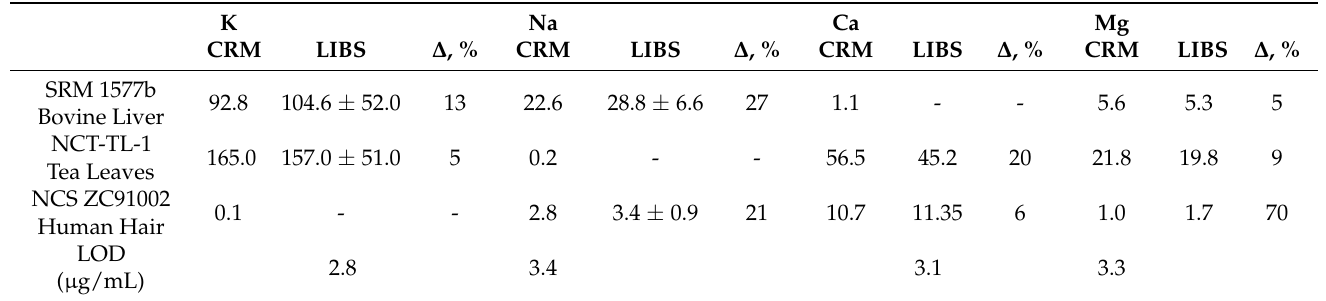
Table 3. Comparison of the results for K, Na, Ca, and Mg content determined by LIBS method in various CRM samples ( µ g/mL).